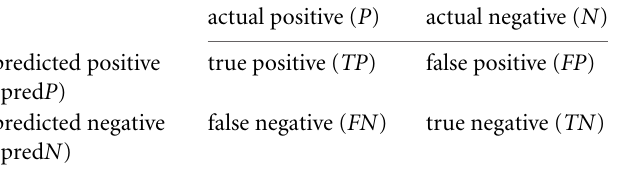
connecting the two points ( 0 , 0 ) and ( 1 , 1 ) (the dotted line in Figure 2A